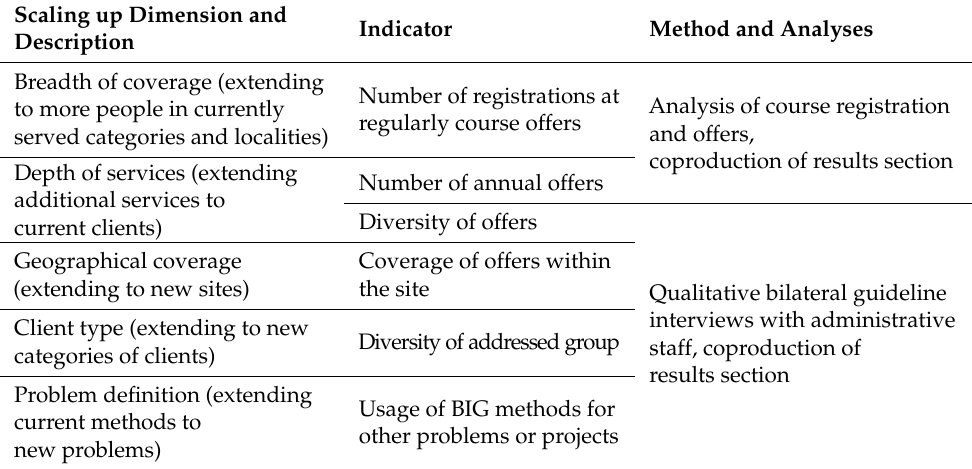
Table 2. Study design (study dimension and description following Kohl and Cooley